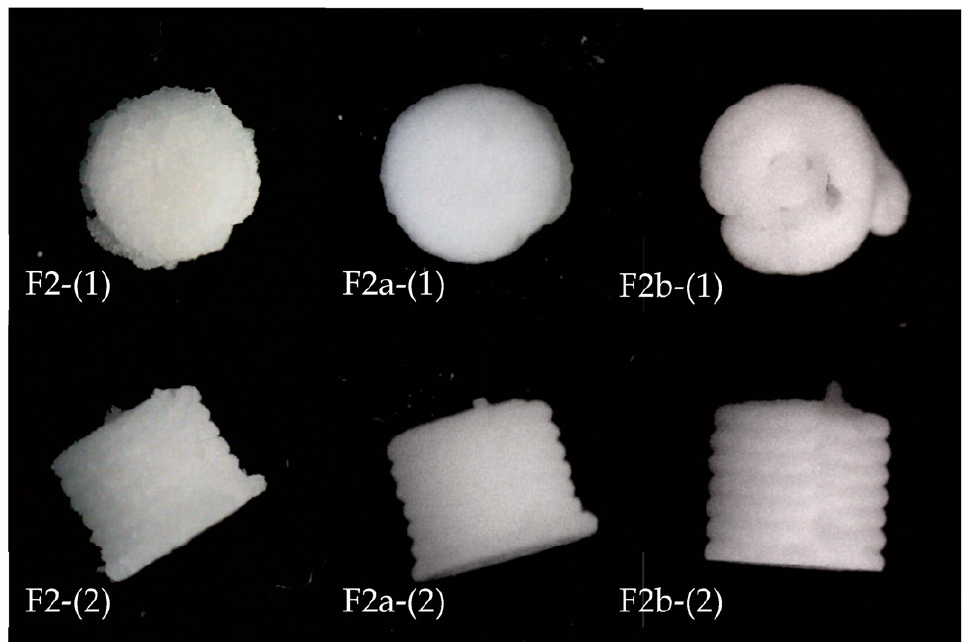
Figure 6. Appearance of F2a and F2b compared with F2 ODMTs (post-drying for 24 h); F2-(1), F2a-(1), F2b-(1): top view; F2-(2), F2a-(2), F2b-(2): side view.